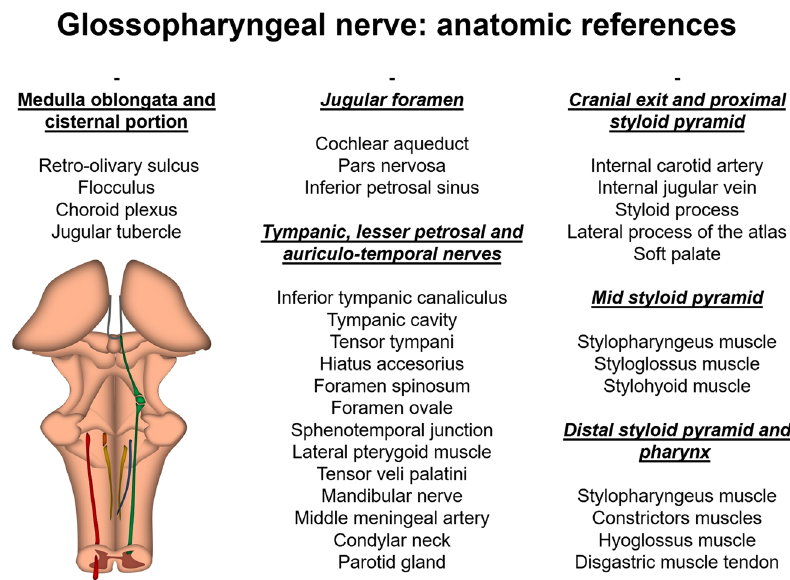
Fig.11 Summaryofthe anatomic references of the glossopharyngeal nerve in the cross-sectional conventional clinical